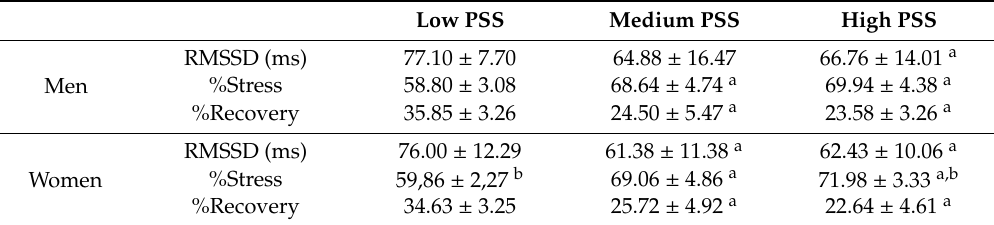
Table 4. Di ff erences in RMSSD, %Stress and %Recovery in the di ff erent PSS groups.